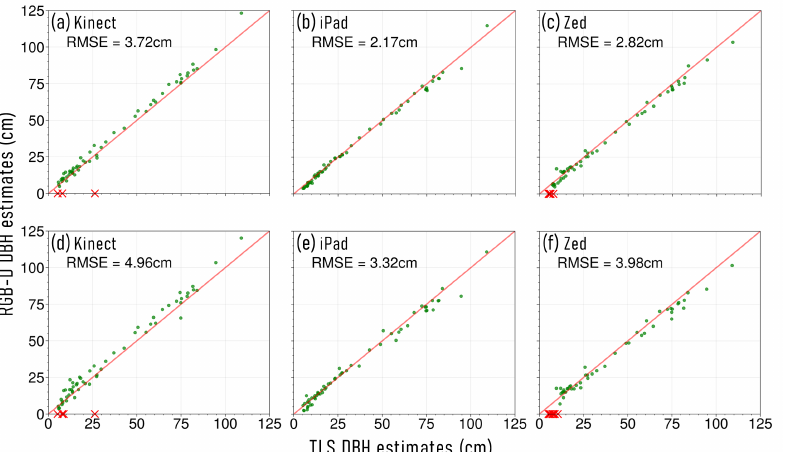
Figure 3. Stem diameter at breast height (DBH) estimates captured at site 1 (S1), in urban parkland, using colour and depth (RGB-D) sensors, and compared to terrestrial laser scanning (TLS) measure- ments. ( a ) Microsoft Azure Kinect individual stem capture, ( b ) Apple iPad Pro 2020 individual stem